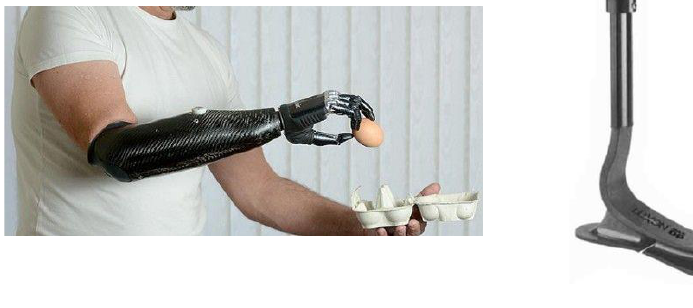
Figure 18. ( a ) Typical defects on transmission pipelines [60], and ( b ) carbon fiber-reinforced composite wraps to repair defected sections of pipelines [61] (adapted with permission from Refs. [60,61]).